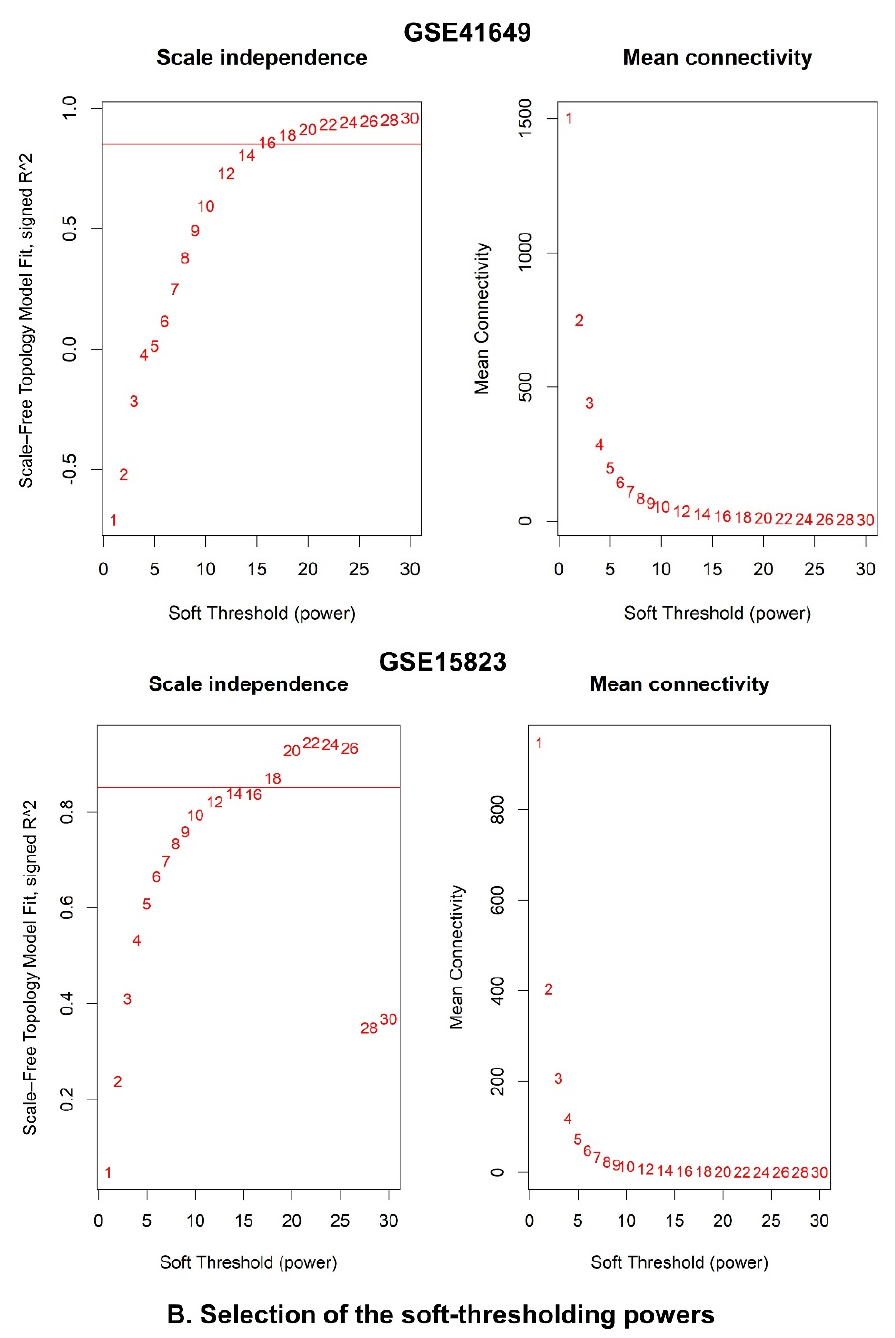
Figure 5. ( A ) The clustering of samples to identify outliners. ( B ) Scale–free fit index ( left ) and mean connectivity analysis ( right ) were used in the soft–threshold power–selection process.